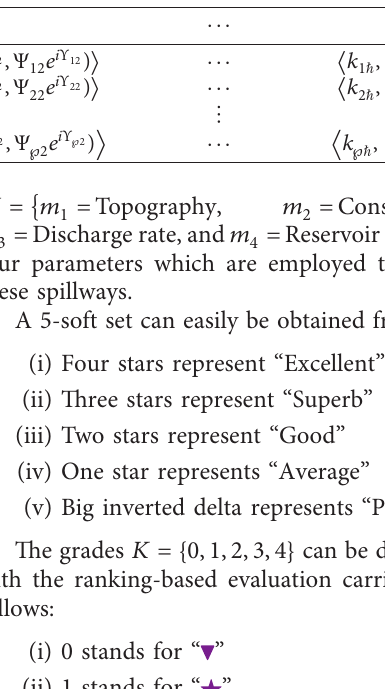
Table 1: Tabular representation of C